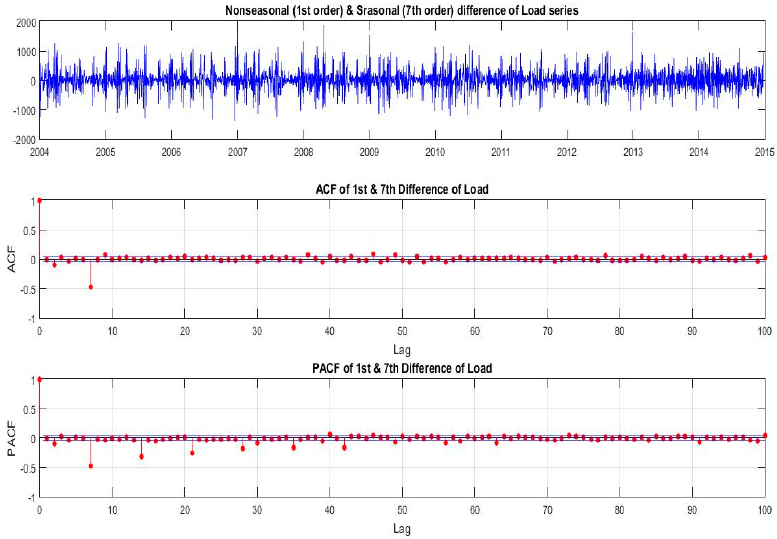
Figure 9. Autocorrelation Function (ACF) and Partial Autocorrelation Function (PACF) of the transformed series.